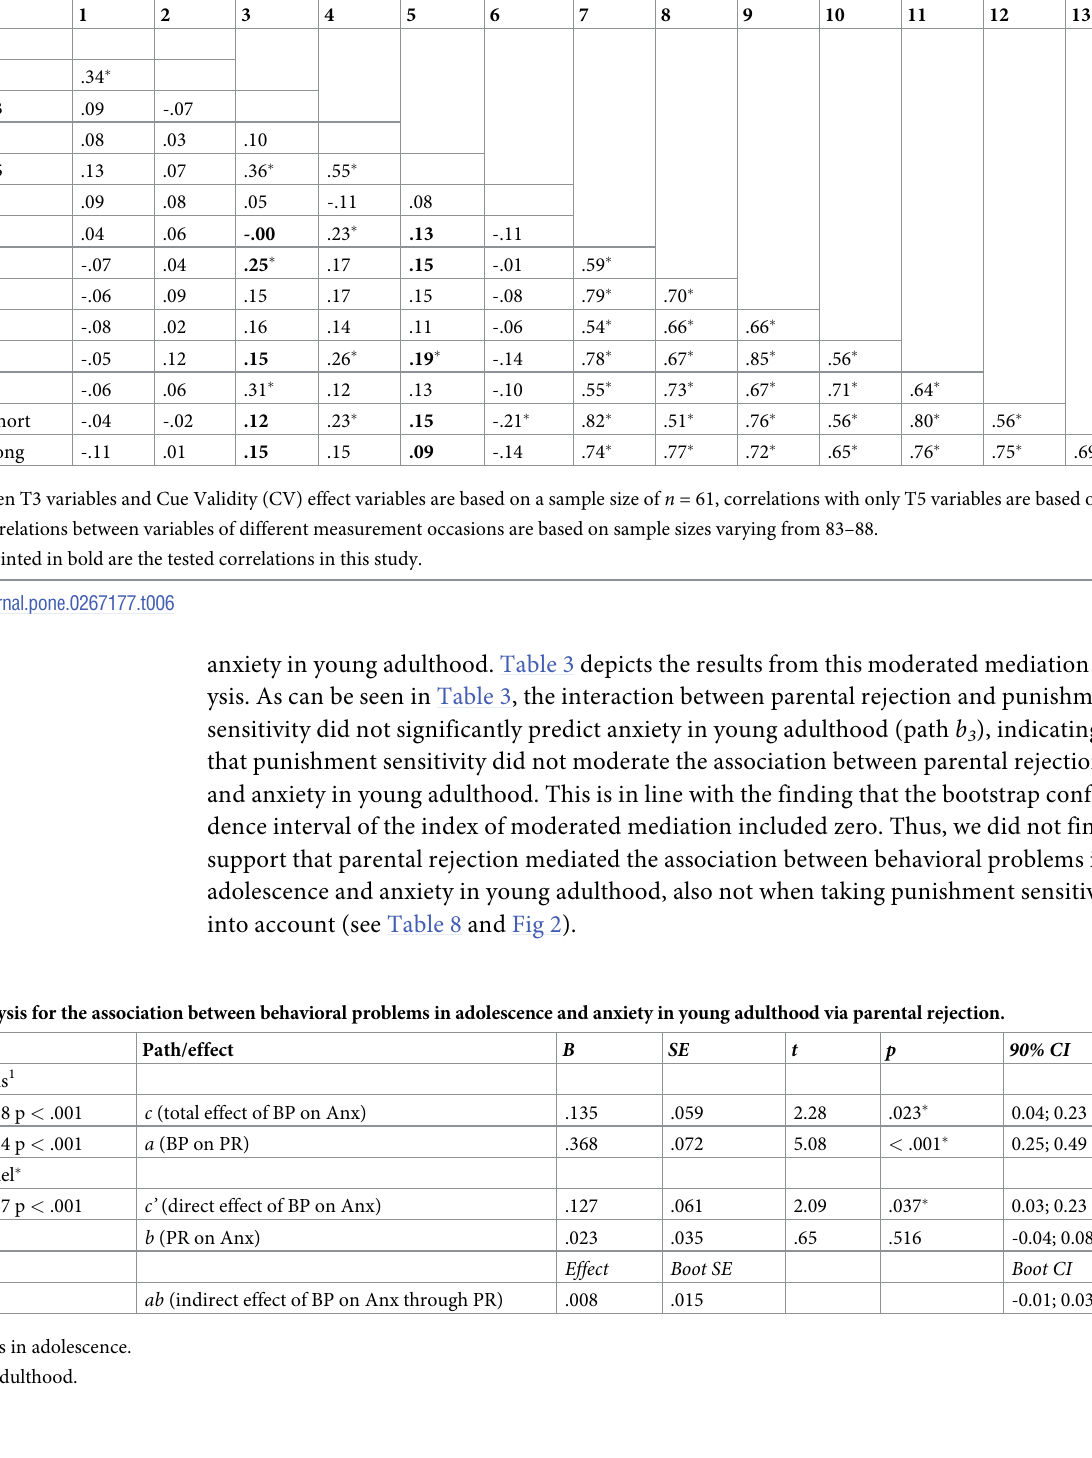
Table 6. Bivariate correlations of cue validity effects with internalizing and behavioral problems at T3 and T5.